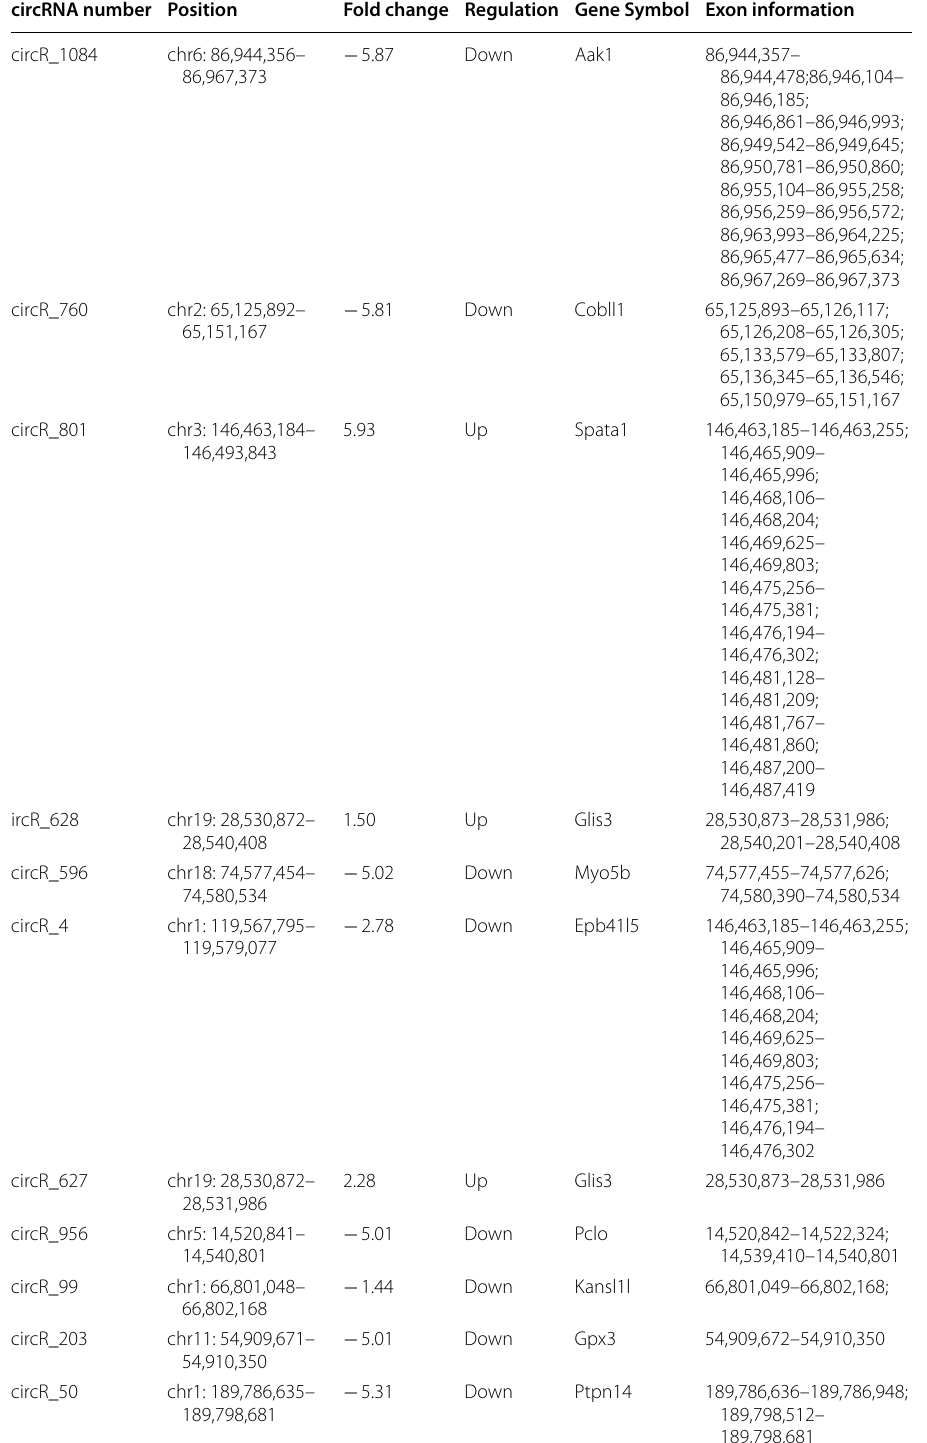
Table 1 Detailed information of differentially expressed circular RNAs (circRNAs) identified by high- throughput RNA sequencing circRNA number Position Fold change Regulation Gene Symbol Exon